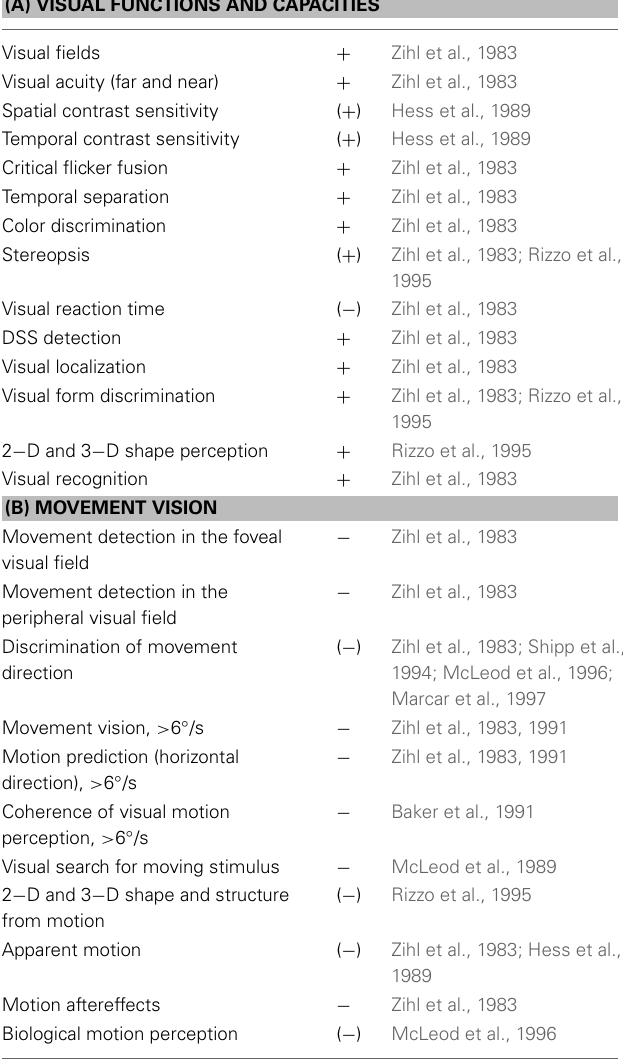
Table 1 | Summary of outcomes of visual (A) and movement vision (B) assessment in LM. (A) VISUAL FUNCTIONS AND